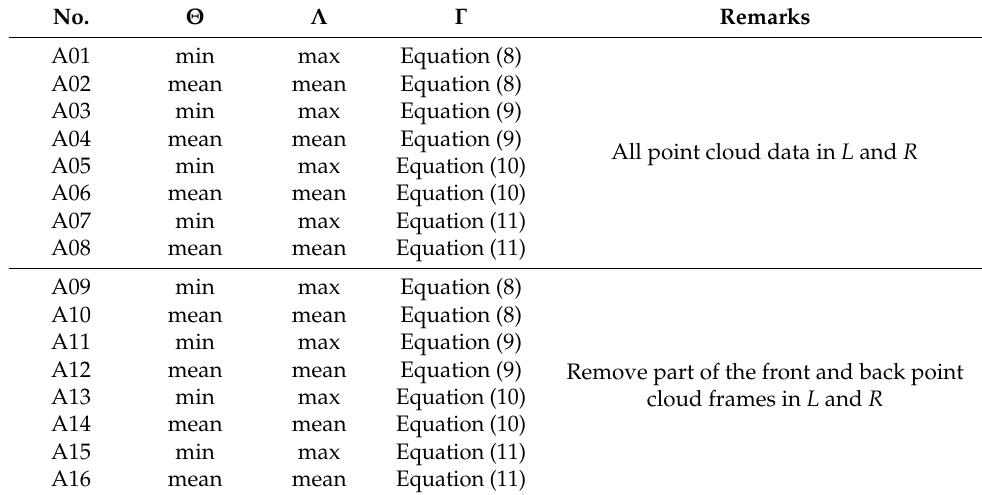
Table 1. combination of Θ , Λ and Γ